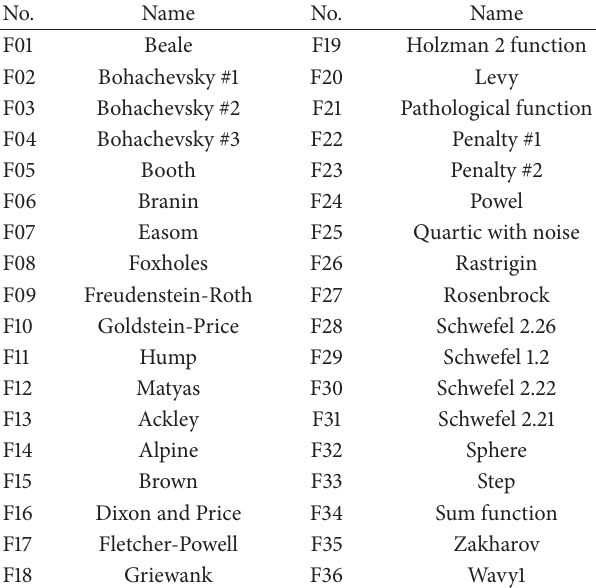
Table 1: Benchmark